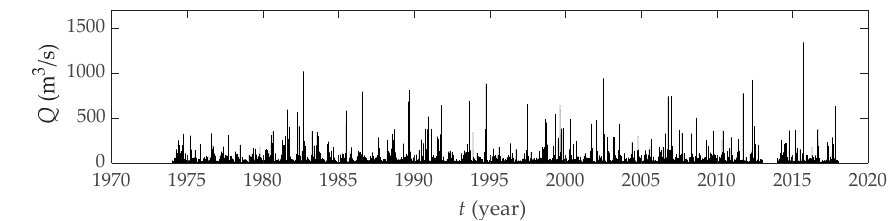
Figure 4. Daily river discharge at Nodabashi Station (1974~2017).